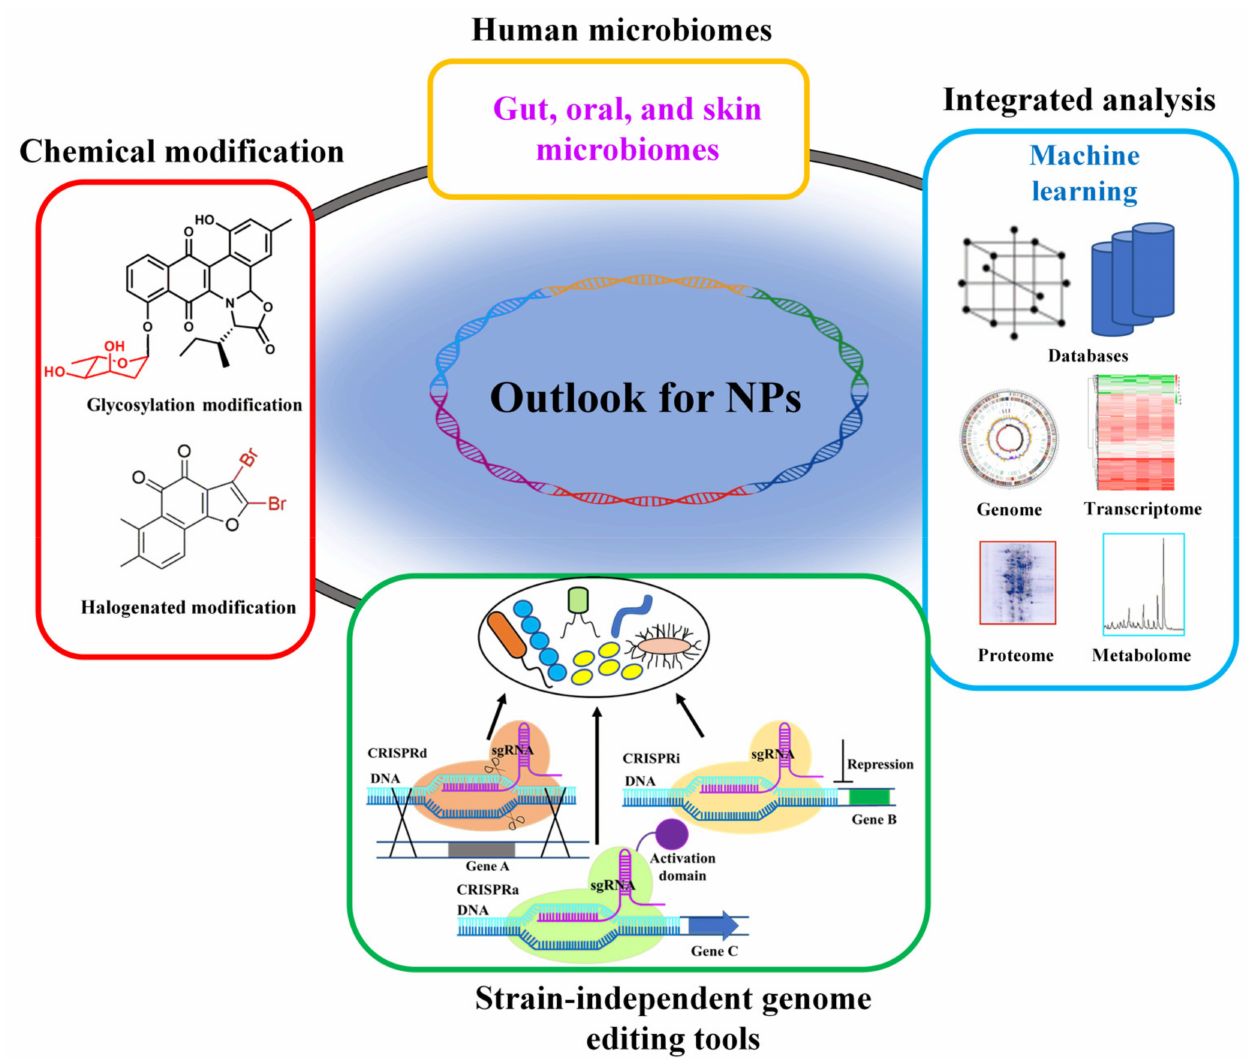
Figure 2. Future perspectives for NPs discovery. In the future, NP repertoire could also be derived from human microbiomes. Existing machine learning methods and databases should be optimized and integrated with the existing omics data, thereby improving the accuracy of the design and accelerating strain development. Strain-independent genome editing tools should also be developed to enable efficient gene editing of nonconventional microbes as well as natural